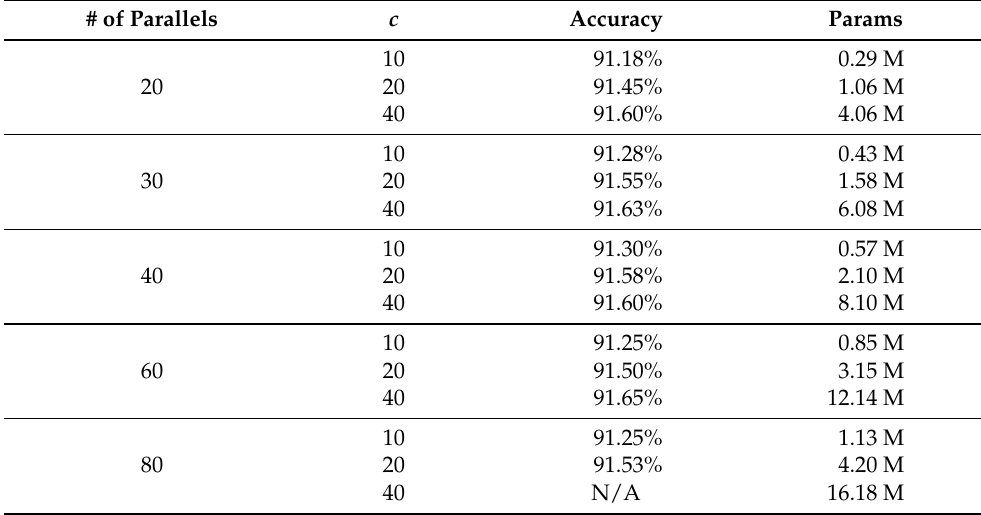
Table 6. Estimation accuracy of MM-CNN with Mean and CPR under varying the number of parallels for